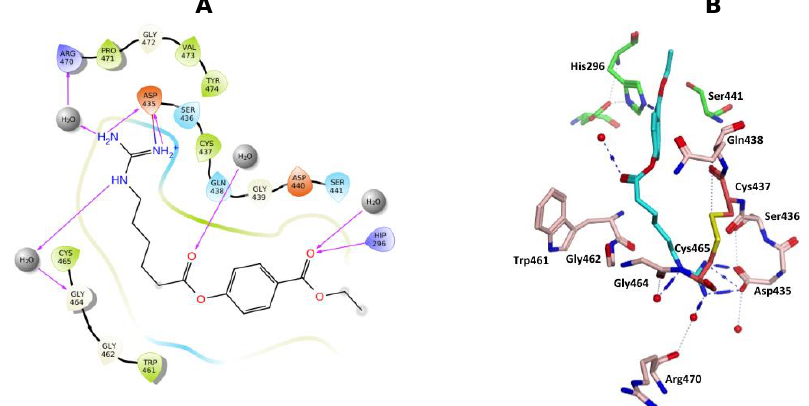
Figure 11. ( A ) 2D Ligand interactions and ( B ) 3D visualization of gabexate.